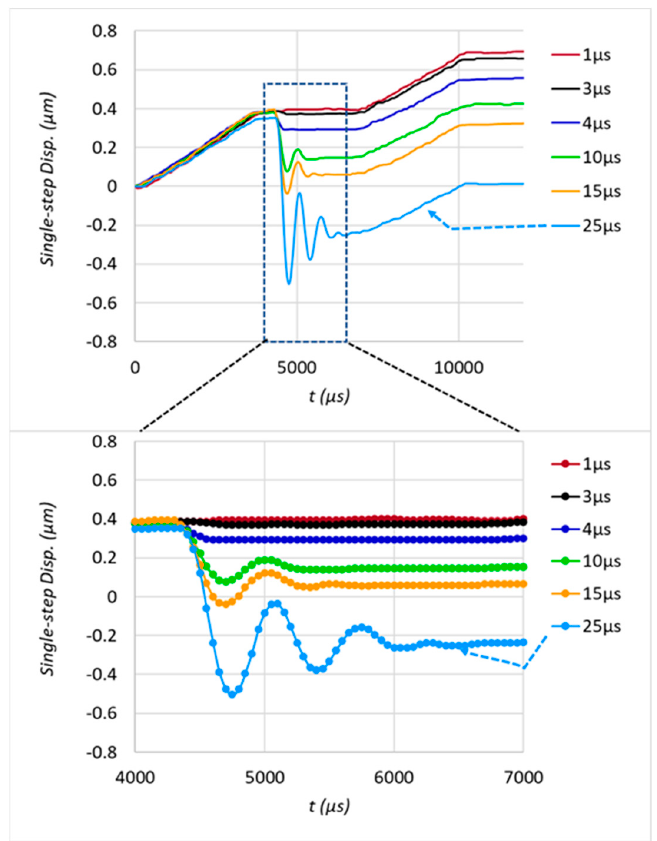
Figure 24. Measured single step slider positions and return movements of the slider for different slip times. When the slip time was greater than 3.0 µs, a return motion of the slider was observed. Even if the slip time is the dominant factor, a return motion can be holding force and operating frequency dependent. Because of the friction nonlinearities and state of the slider (on move or at rest) return movements amount can also vary. The tendency here is the longer the slip time the more the amount of the return movement.